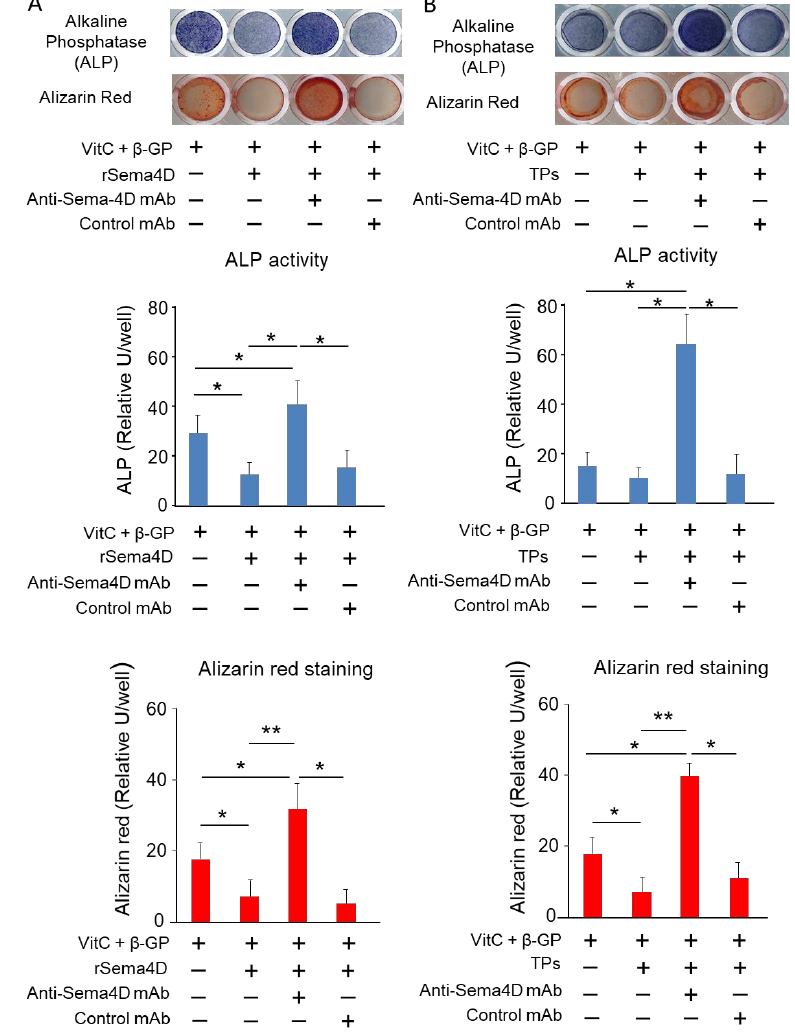
Figure 2. The effect of Sema4D-neutralized TPs on osteoblastogenesis. MC3T3-E1 cells were cultured with and without recombinant human Sema4D (10 ng/mL). After 7 days, ALP staining was performed, and after 21 says, alizarin red staining was performed ( A ). MC3T3-E1 cells were cultured with and without platelets (1 × 10 4 cells) and anti-Sema4D antibody (50 ug/mL) or control IgG (50 ug/mL). After 7 days, ALP staining was performed, and after 21 days, alizarin red staining was performed ( B ). Data represent the mean ± SD of three independent experiments. Values are mean ± S.D. * p < 0.05, ** p < 0.01. +: Applied. − : Not applied.